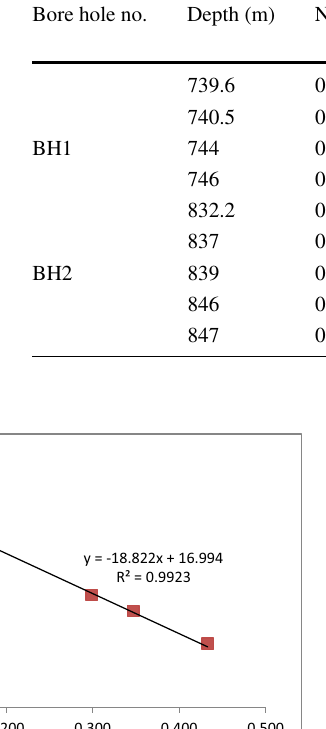
Table 3 Calculated gas storage capacity and non-coal content